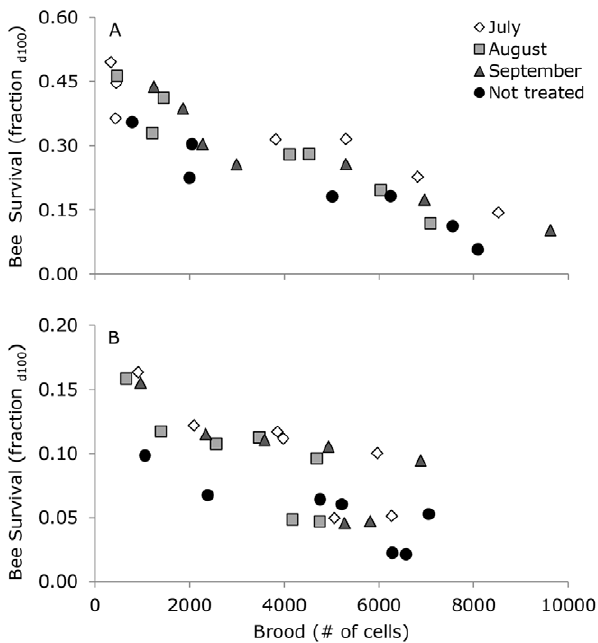
Figure 6. Bee survival as a function of brood in 2005/2006 (A) and 2006/2007 (B). Bee survival (fraction d100), the predicted fraction of bees that was still alive at the age of 100 days, as function of the number of capped brood cells for the different months of acaricide application. Symbols show means per marking day.